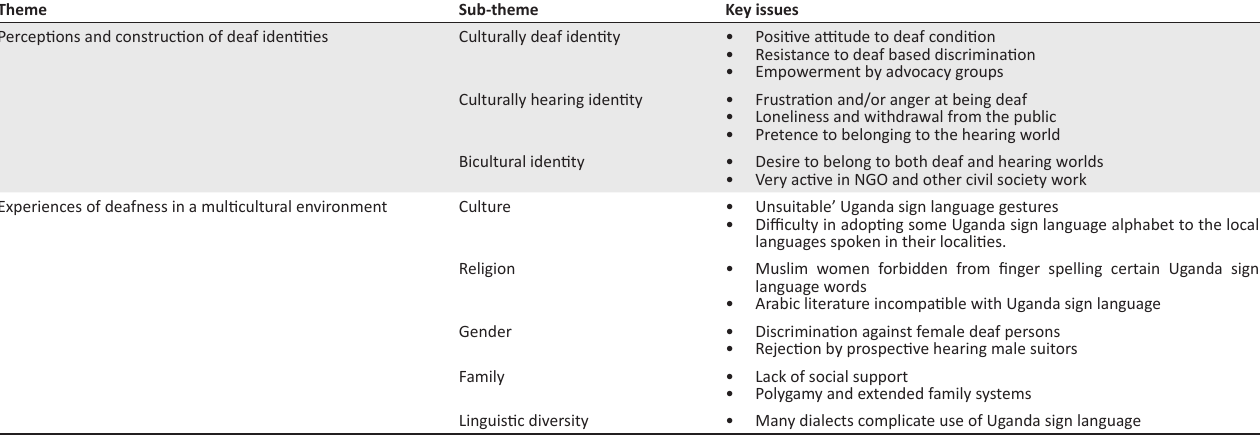
TABLE 1: Themes, sub-themes and key issues of the study. Theme